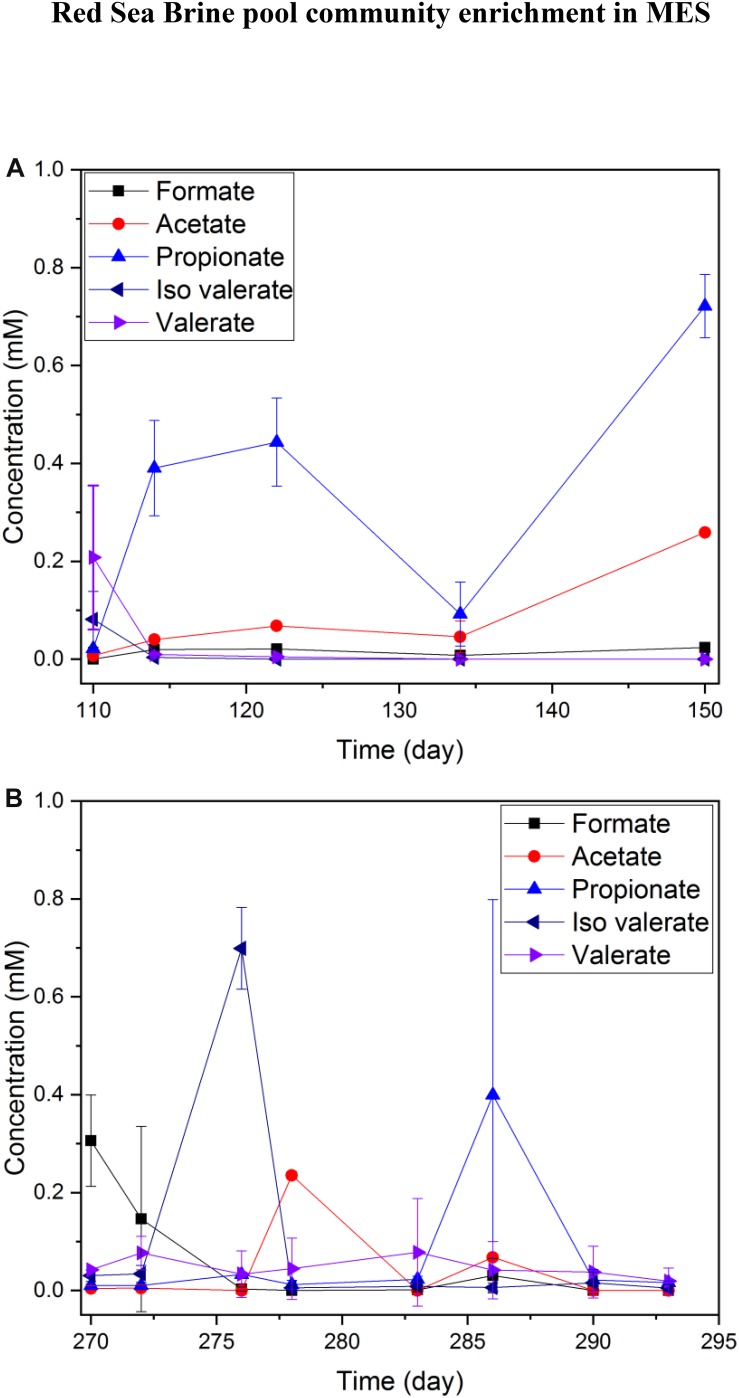
Average VFA production of duplicate MES reactors (R1 and R2) in phase I during a batch of operation with (A) brine pool solution (25% salinity) and (B) synthetic saline media (10% salinity). The data presented in (A,B) are based on one batch of operation, which is representative of several reproducible batches of operation.